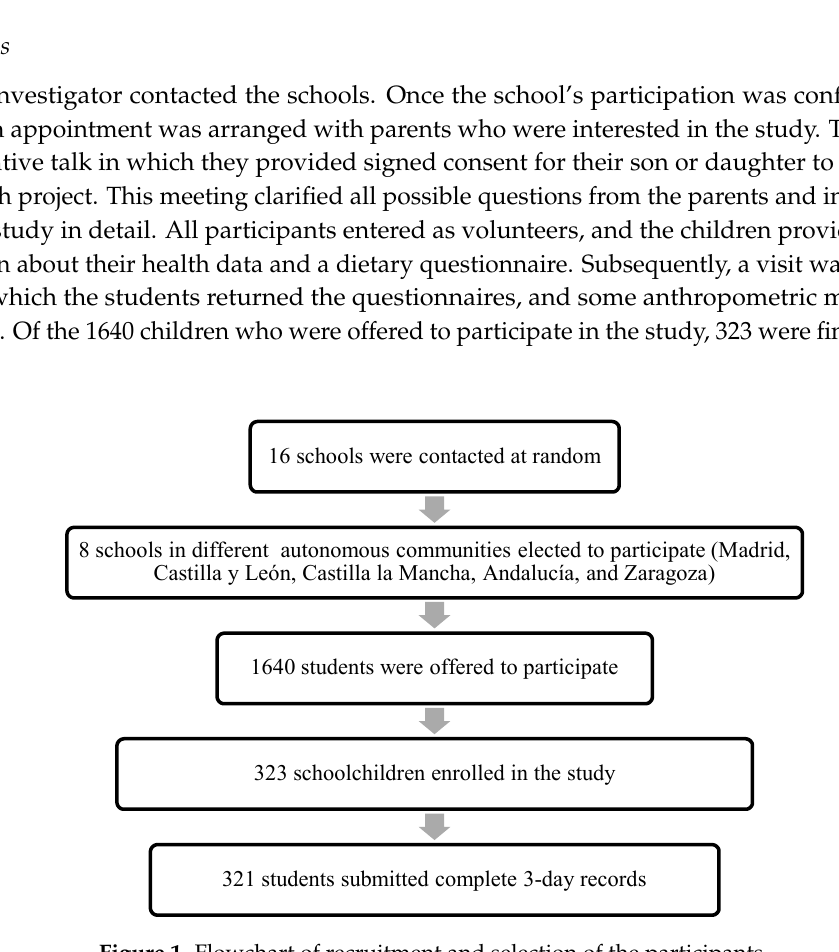
Figure 1. Flowchart of recruitment and selection of the participants.